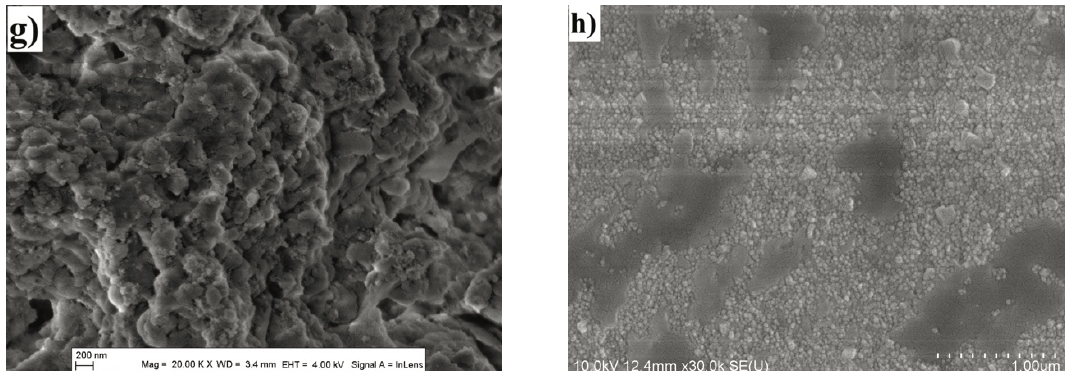
Figure 9. SEM micrographs obtained from samples of SDC—LiNaK composite electrolyte after synthesis ( a ) and after thermal cycling EIS experiments under 20%—humidified synthetic air ( b ); dry ( c ) and humid ( d ) 23%-H 2 -in-N 2 ; dry 50%-H 2 -in-N 2 ( e ); dry 100% H 2 ( f ); and under MCFC simulated cathodic ( g ) and anodic ( h ) atmospheres.